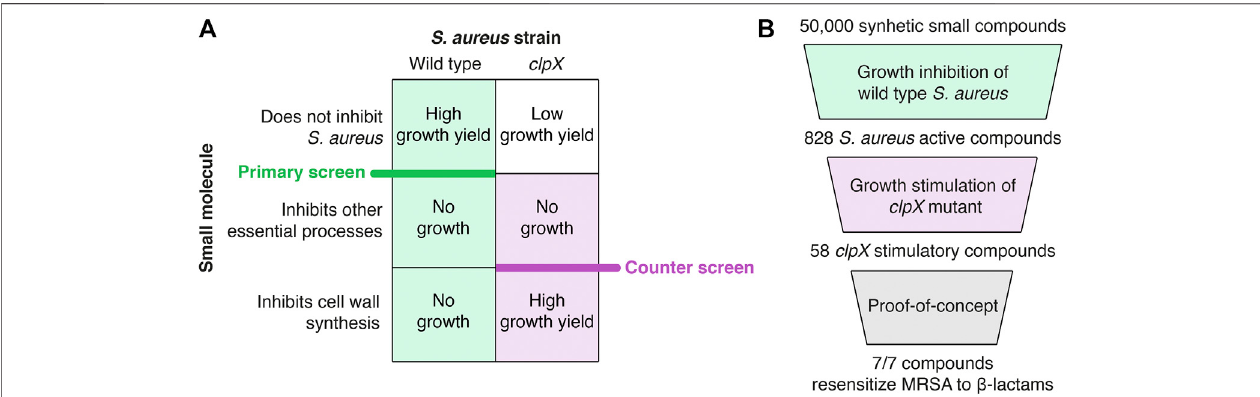
FIGURE1| Summaryofthescreeningprocedure. (A) Principlesofthepathway-speci fi cscreen.Thescreenispredictedtoidentifyinhibitorsofspeci fi cstepsincell wallsynthesis becausesuch compounds inhibit the growth ofthewild type strain (primary screen) while improving growth ofthe clpX strain(counterscreen) – see text for details. (B) Screeningwork fl ow.Acollectionof50,000syntheticsmallmoleculesfromtheMaybridgescreeningcollection was fi rstscreenedforgrowthinhibitionagainst the S. aureus wild type resulting in 828 active compounds. Next, a S. aureus clpX mutant was used in a growth-based counter-screen to identify 58 compounds capableofincreasingthegrowthyieldofthe clpX mutantat30 ° C(cut-off1.5foldincreasein fi nalyieldasmeasuredbyopticaldensity).Tencompoundswerepurchased for follow-up studies, and of these ten compounds, seven hit-compounds retained the ability to increase the fi nal yield of S. aureus clpX cultures grown at 30 ° C in a microtiter plate growth assay and sensitized the highly resistant COL MRSA to at least one β -lactam antibiotic in a disc diffusion assay (summarized in Table 1 ).